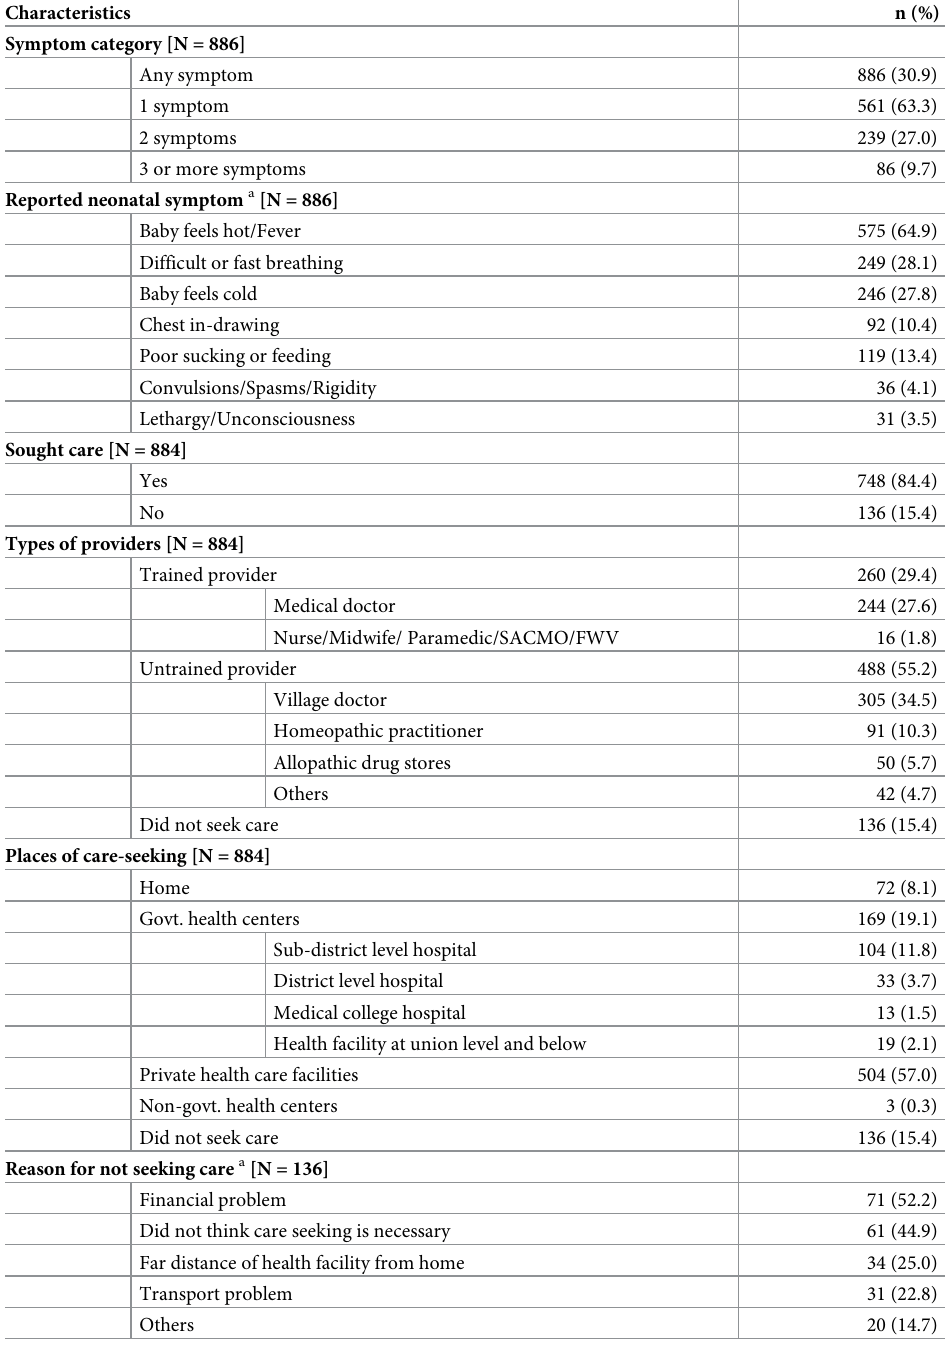
Table 2. Reported symptoms and mother’s preferences of care-seeking for their sick neonates, MNCS Endline Survey in 2012.